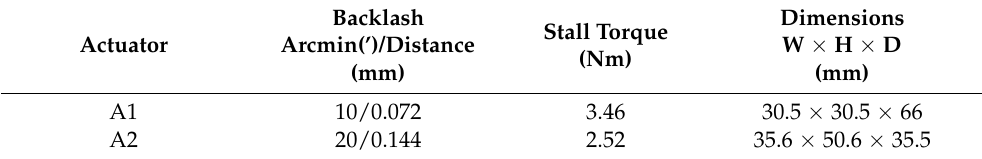
Table 1. Actuators’